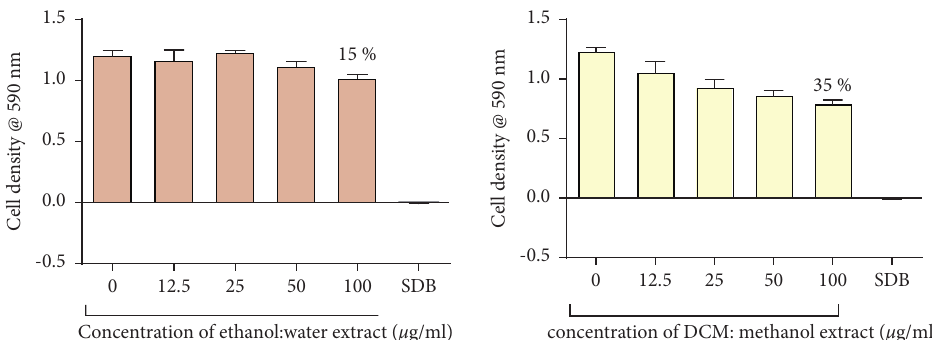
Figure 6: The effect extracts from C. citrinus on C. tropicalis . Percentage inhibition of 15% and 35% was observed at 100 μ g/ml of the ethanol: water extract and DCM: methanol extract, respectively. The data shown in this graph represent the mean for four replicates. These data were analysed using one-way ANOVA followed by Dunnett’s test for multiple comparisons, comparing means to the negative control (SDB).